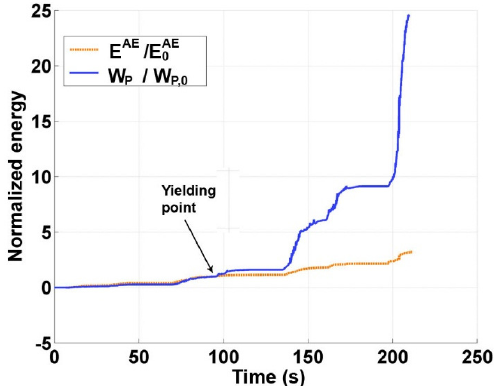
Figure 21 . Accumulated AE energy (dashed line) and accumulated plastic strain energy (solid line).